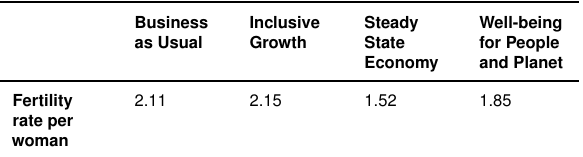
Table 6. Fertility rate under different scenarios of the